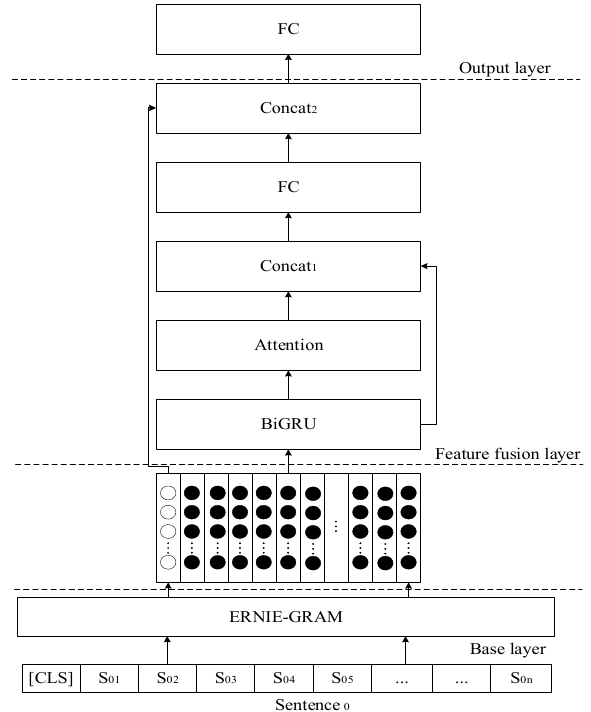
Figure 1. EBA model structure.